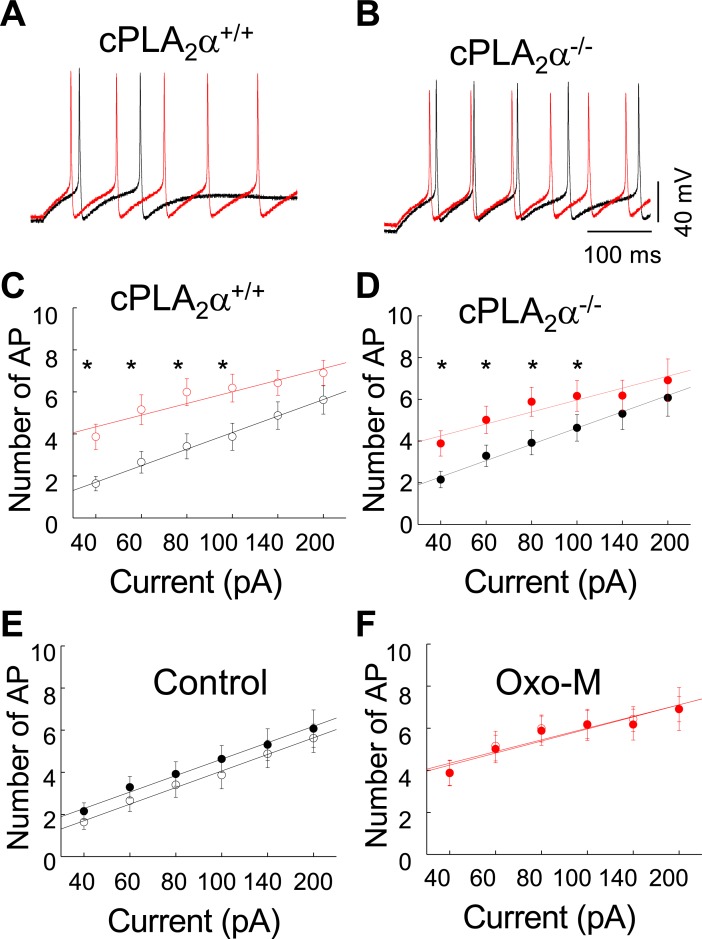
The absence of cPLA2α alters AP firing in SCG neurons.(A-B) Examples of SCG AP firing elicited with 100 pA. Black traces, control; Red traces, 2 min after Oxo-M. (C-D) Current-frequency plots show that firing frequency increases with Oxo-M (red circles). (E) Current-frequency plots show that cPLA2α-/- neurons (solid circles) exhibit slightly elevated firing frequency over cPLA2α+/+ neurons (open circles). (F) Firing frequency of cPLA2α-/- (solid circles) and cPLA2α+/+ (open circles) cells following Oxo-M.